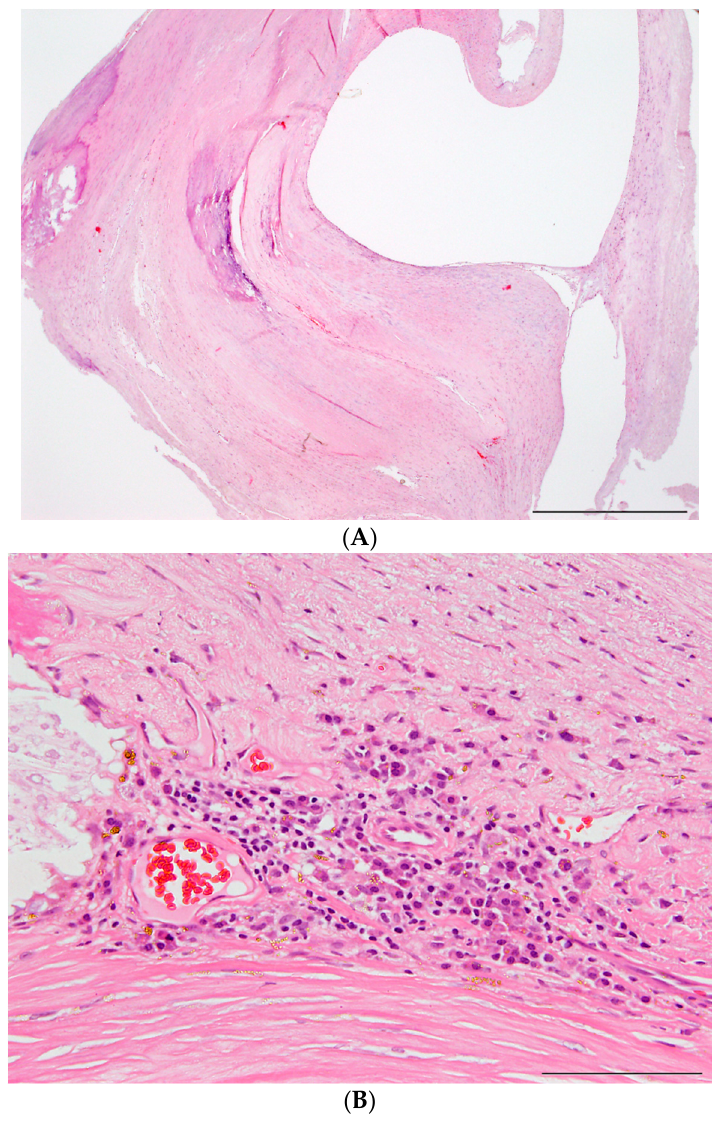
Figure 4. Cont. Figure 4.